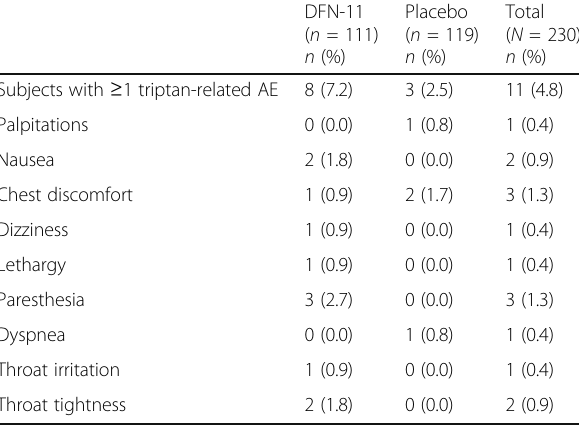
Table 3 Triptan-related adverse